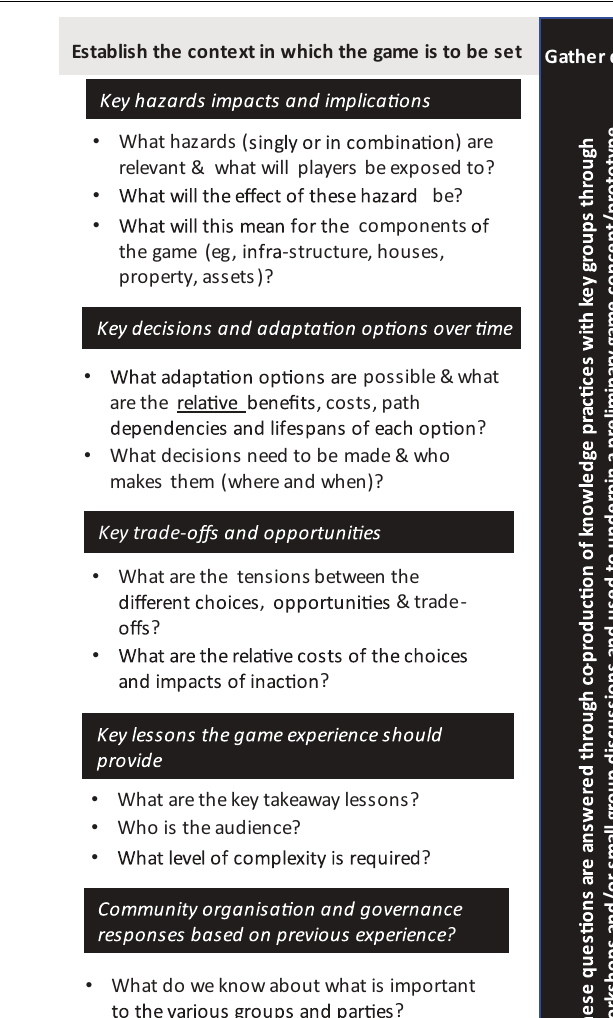
the development of signals and triggers for monitoring DAPP pathways by decision makers (Stephens et al.,